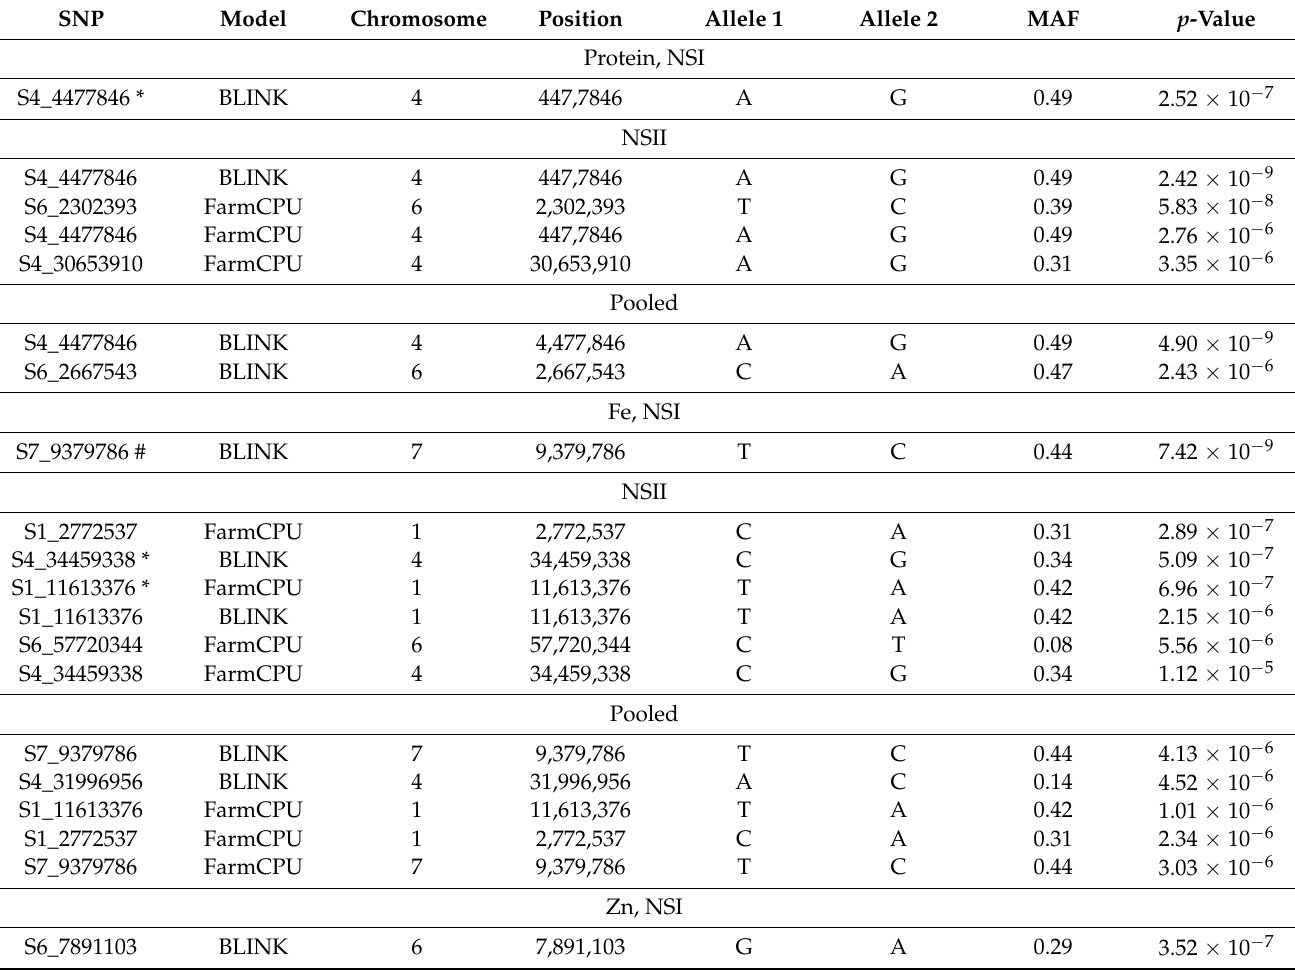
Table 3. MTAs for nutrient traits under NSI, NSII, and pooled seasons by BLINK and FarmCPU